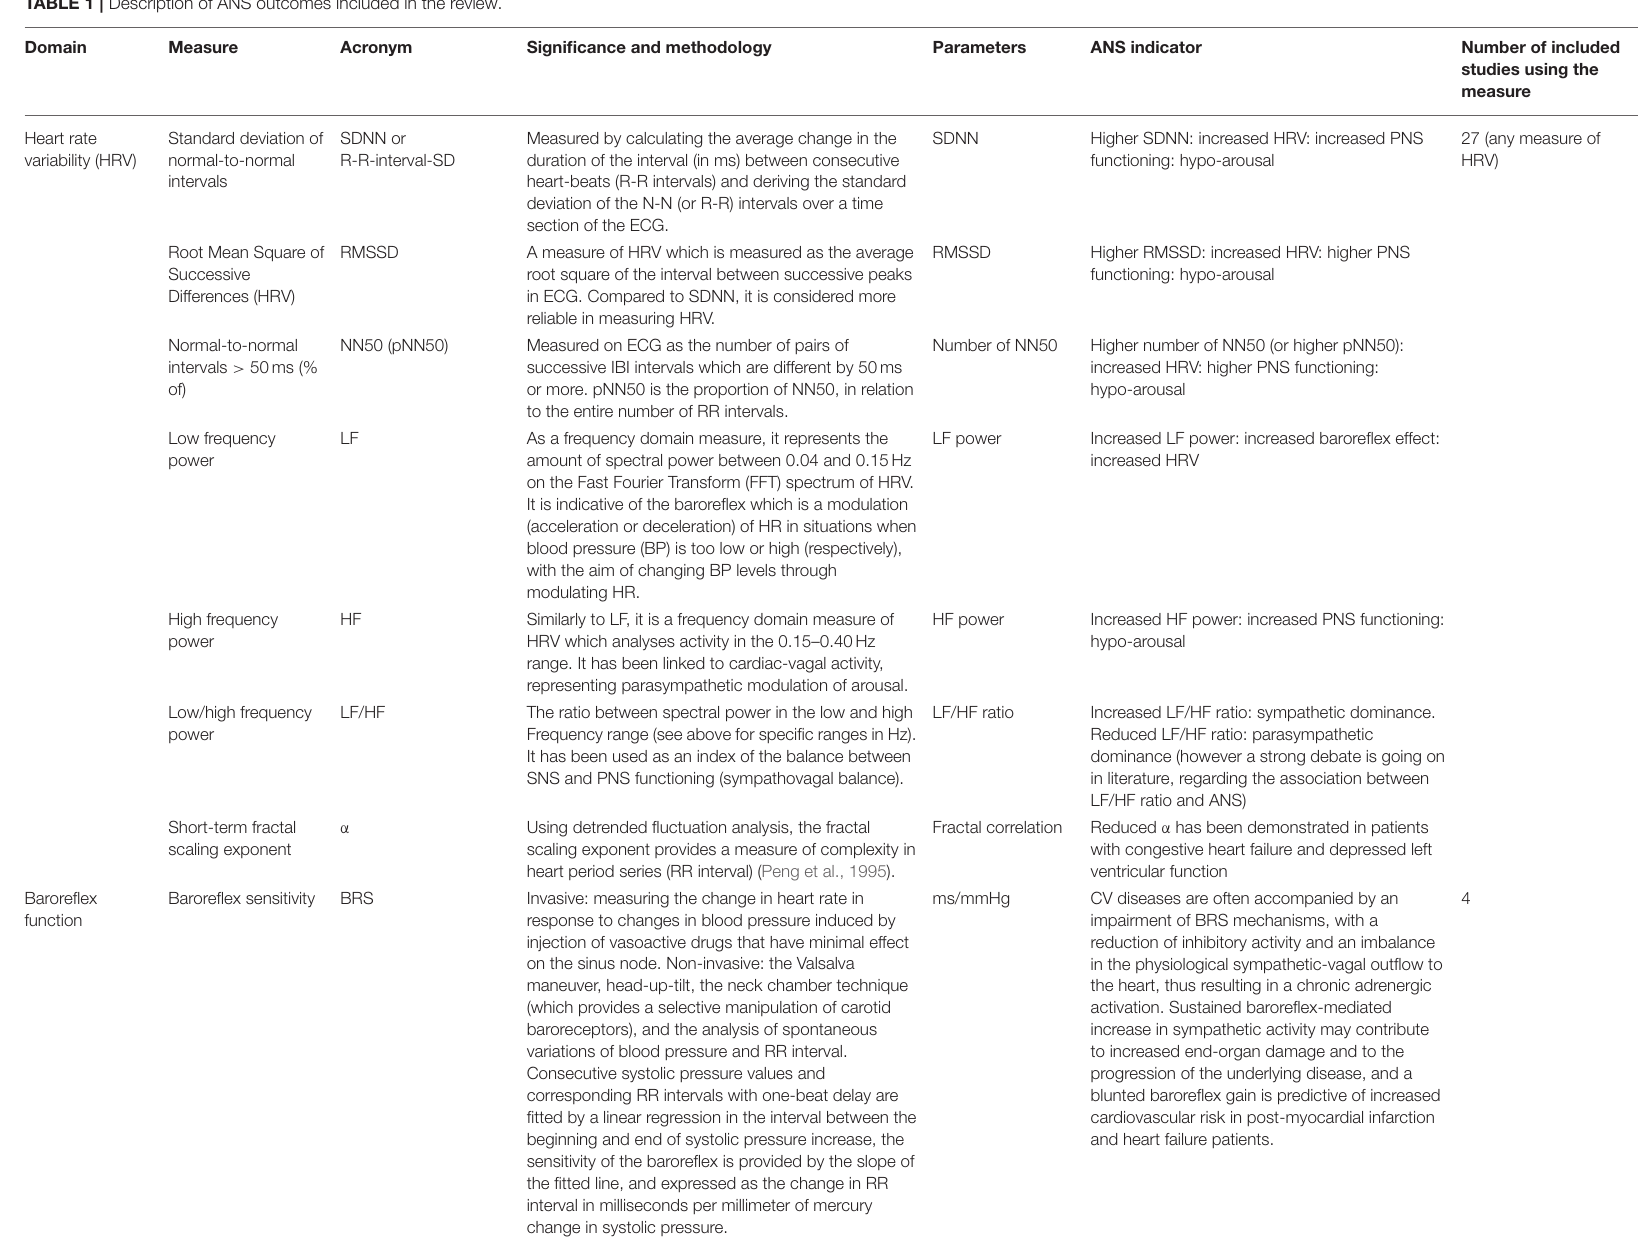
TABLE 1 | Description of ANS outcomes included in the